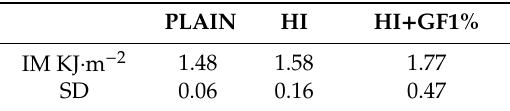
Figure 17. Impact strength of plain acrylic denture base resin, high-impact denture base resin and its composite with acrylic coated glass flakes. Table 5. Impact strength of plain acrylic denture base resin, high-impact denture base resin and its composite with acrylic coated glass flakes.